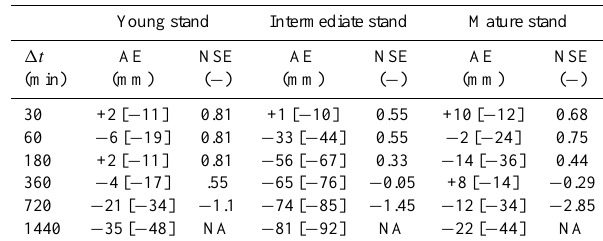
Table 4. Sensitivity of the data-driven soil water balance model to the computational time step ( 1t ). The absolute error and NSE shown is the lowest obtained by the combination of Z r and I max for each time step. The relative error is shown in Fig. 3. The absolute error (AE) after the correction from the slope of the energy balance is shown in